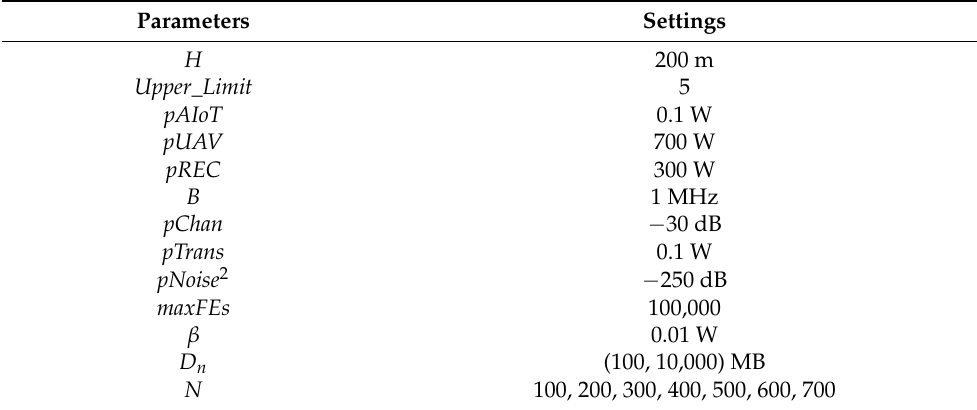
Table A2. Summary of all parameters used in the